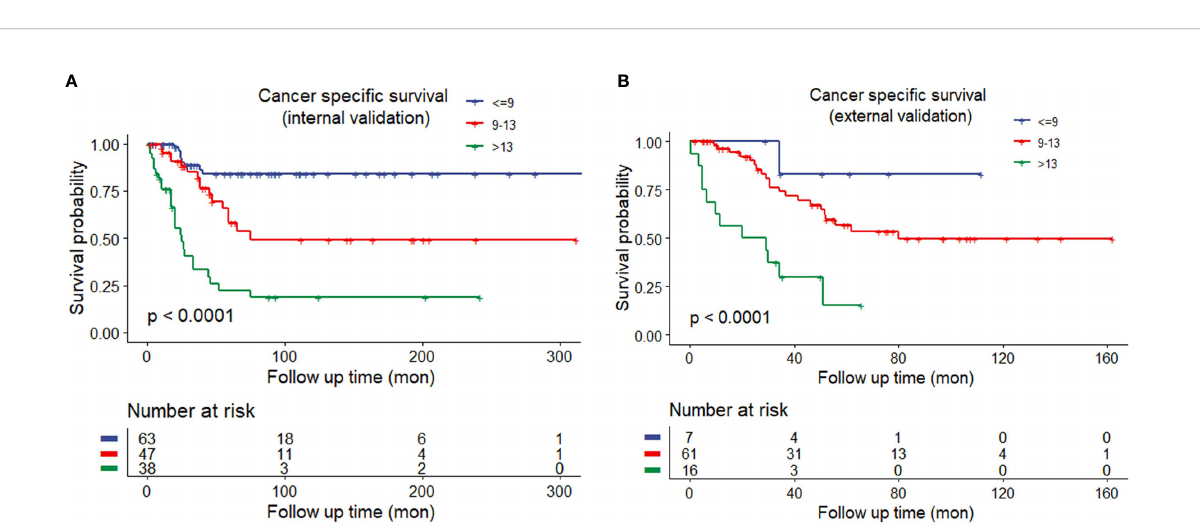
FIGURE 4 | (A) Kaplan – Meier curves of different risk groups strati fi ed by the Sheldon model in the internal training cohort. (B) Different risk groups strati fi ed by the Sheldon model in the external validation